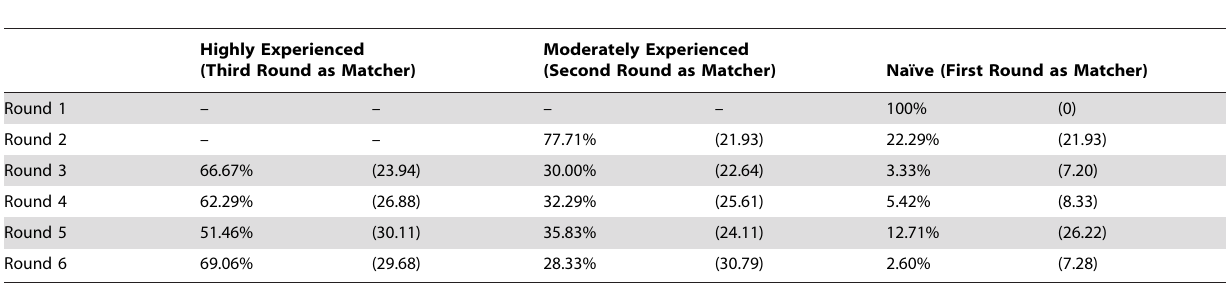
Table 2. Mean percentage of responses (correct target trials only, N =16 microsocieties) made by naı¨ve, moderately experienced, and highly experienced matchers across rounds 1–6.